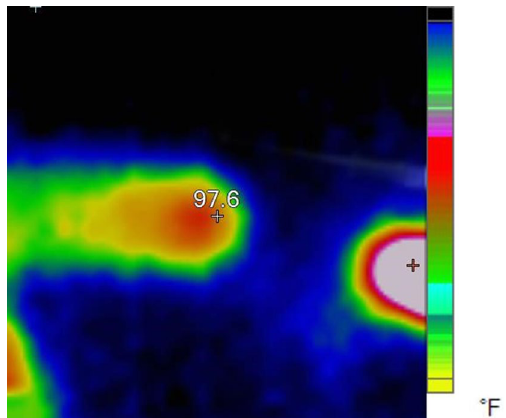
Figure 6. Thermal image of the finger as a reference.